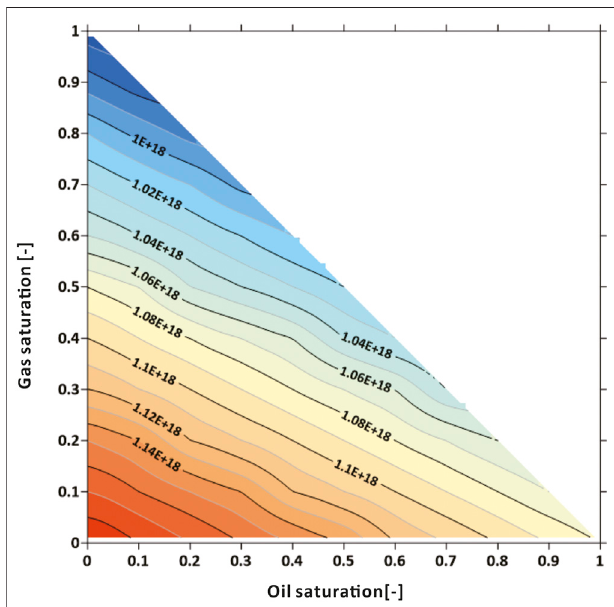
FIGURE 11 | The estimated geothermal resources varying with gas and oil